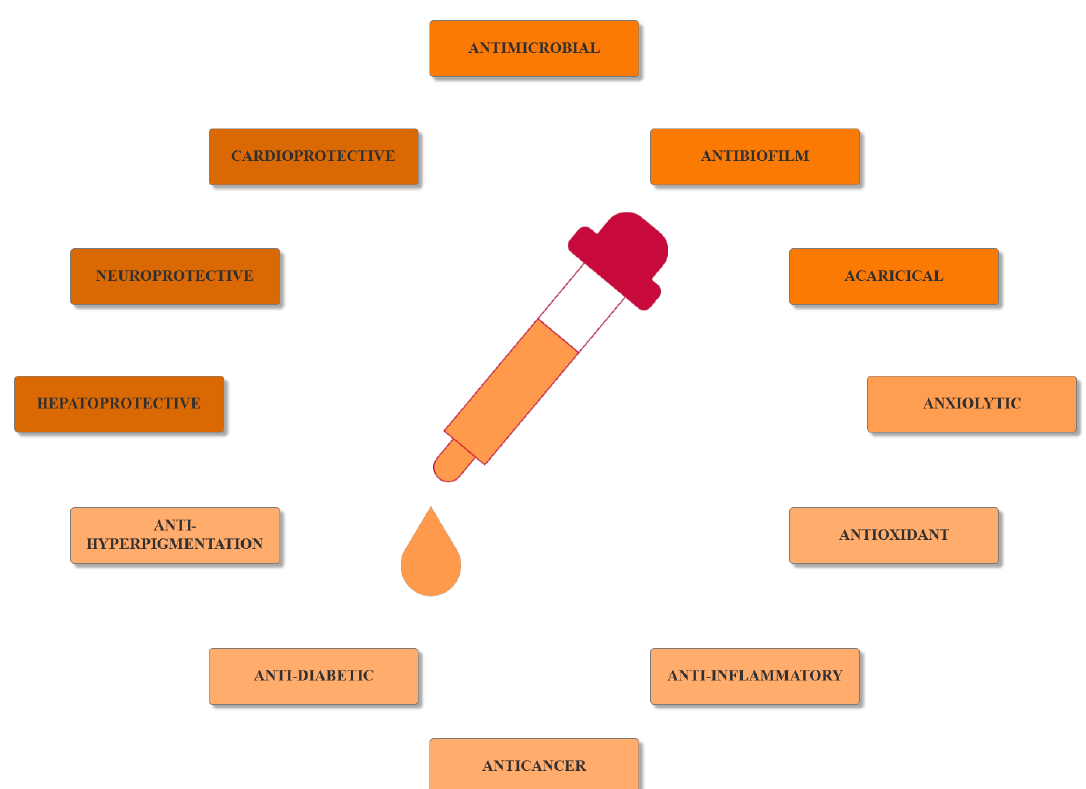
Figure 2. The main bioactive properties of EOs. Reprinted from an open-access source [45].